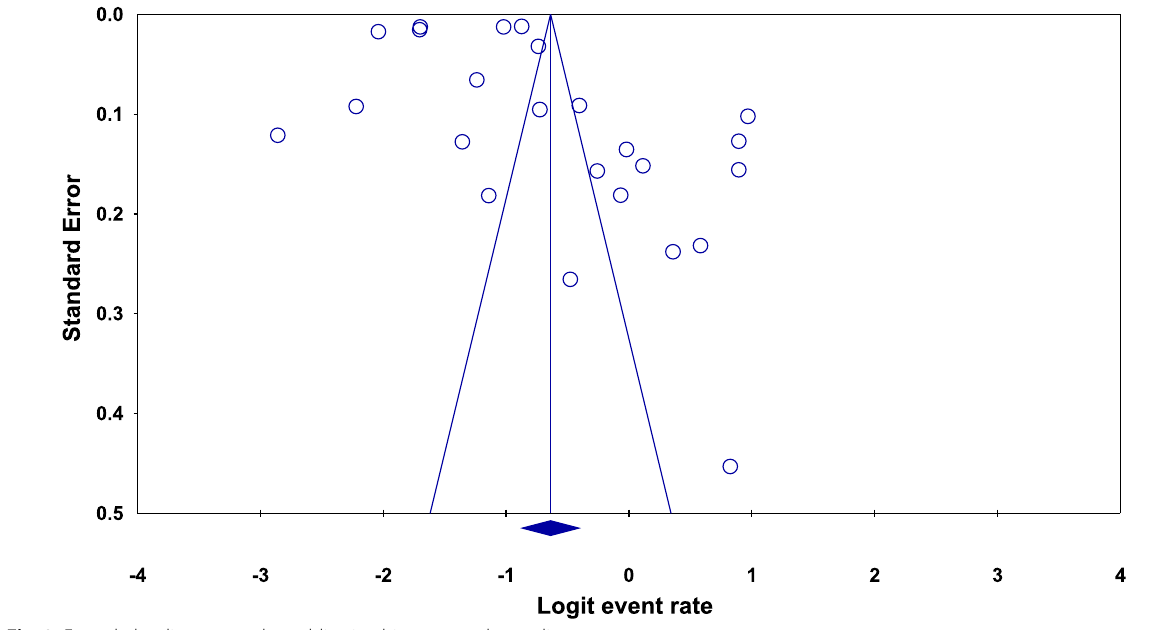
Fig. 2 Funnel plot diagram on the publication bias among the